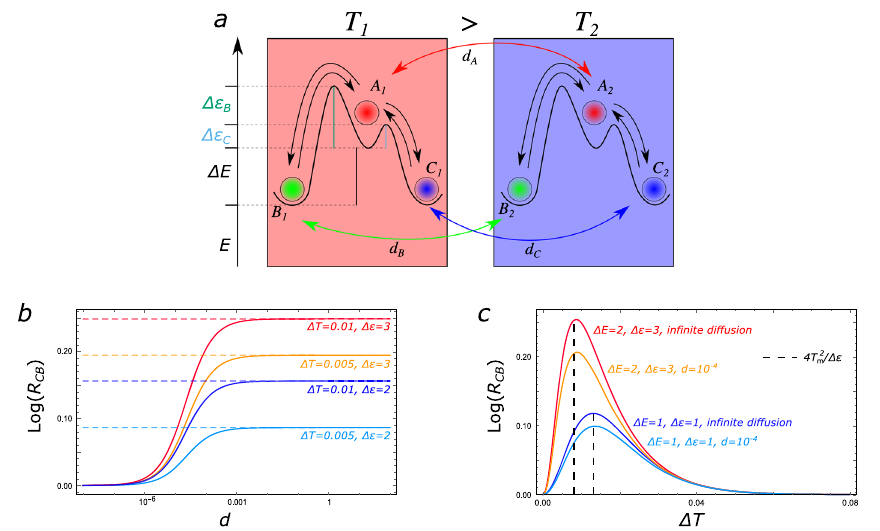
A and B , Δ ϵ Δ ϵ = Δ ϵ − Δ ϵ R = ( P ( C + P ( C P ( B + P B (green/dark gray), i.e., B C . b The quantity CB 1 ) 2 ))/( 1 ) (cid:4) (cid:5) is plotted as a function of the thermal gradient for different choice of parameters. The